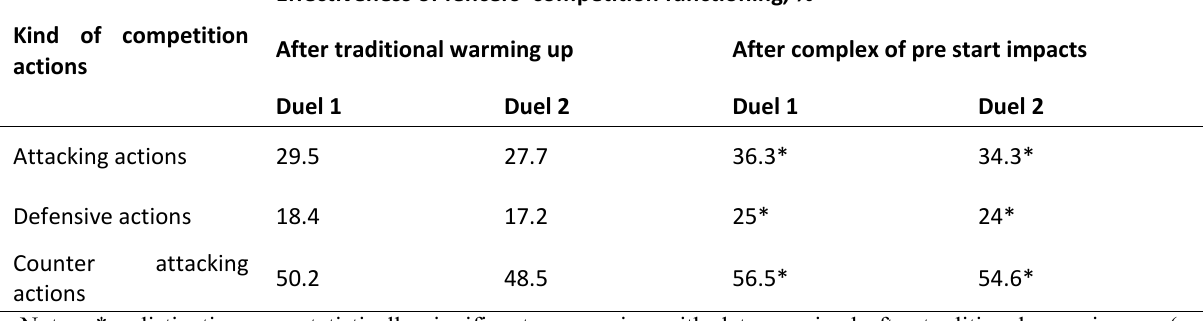
Table 1. Indicators of competition functioning of elite fencers (n = 12) Kind of